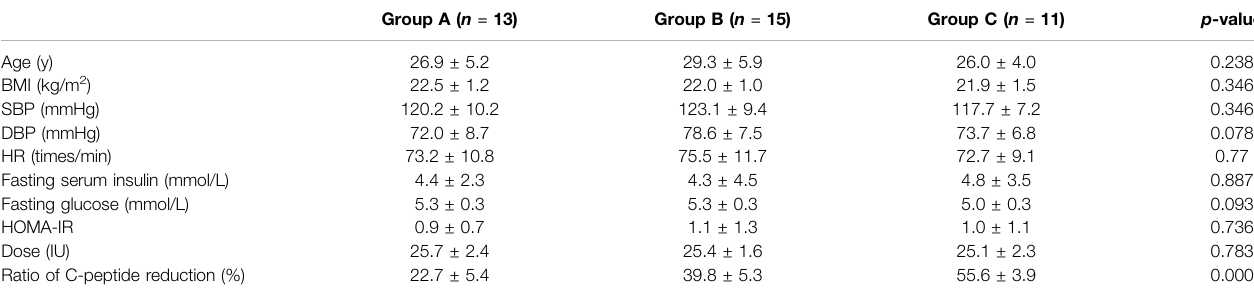
TABLE 1 | Demographics and clinical characteristics of the subjects.